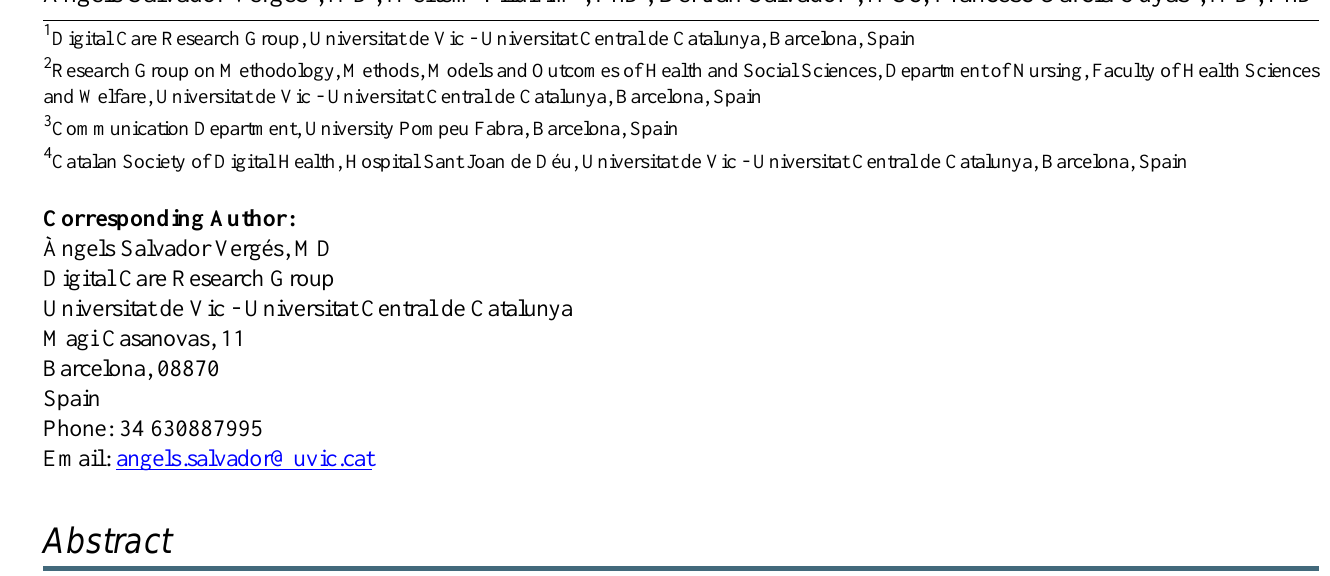
cartilage 3D printing; knowledge; tissue engineering; surgery; cartilage repair; chondrogenesis; cartilage